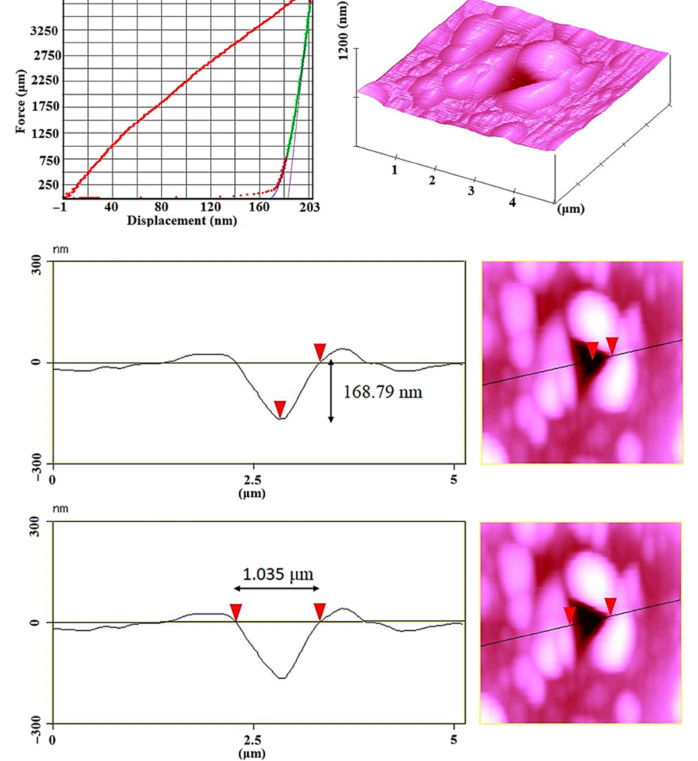
Figure 8. Loading–unloading curve, AFM image, and its associated cross section for a (Fe,Ti) 3 Al